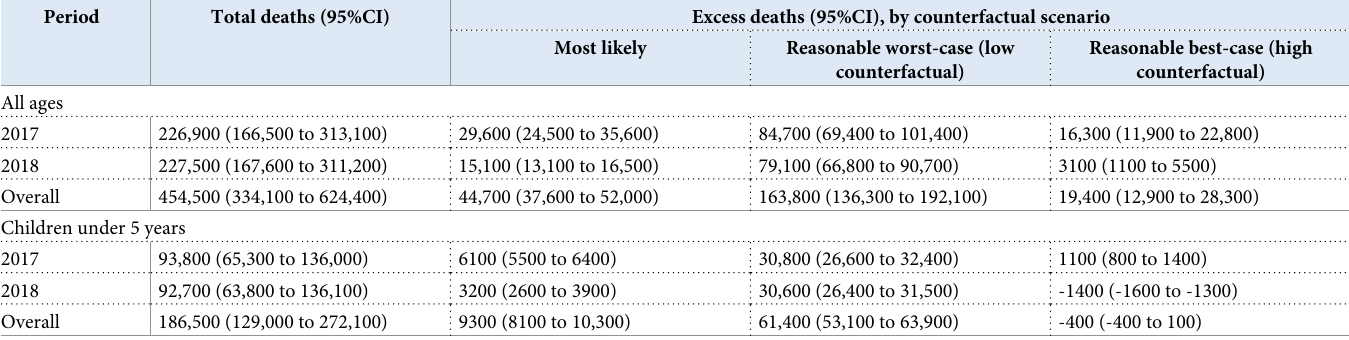
Table 5. Total and crisis-attributable deaths, by year and counterfactual